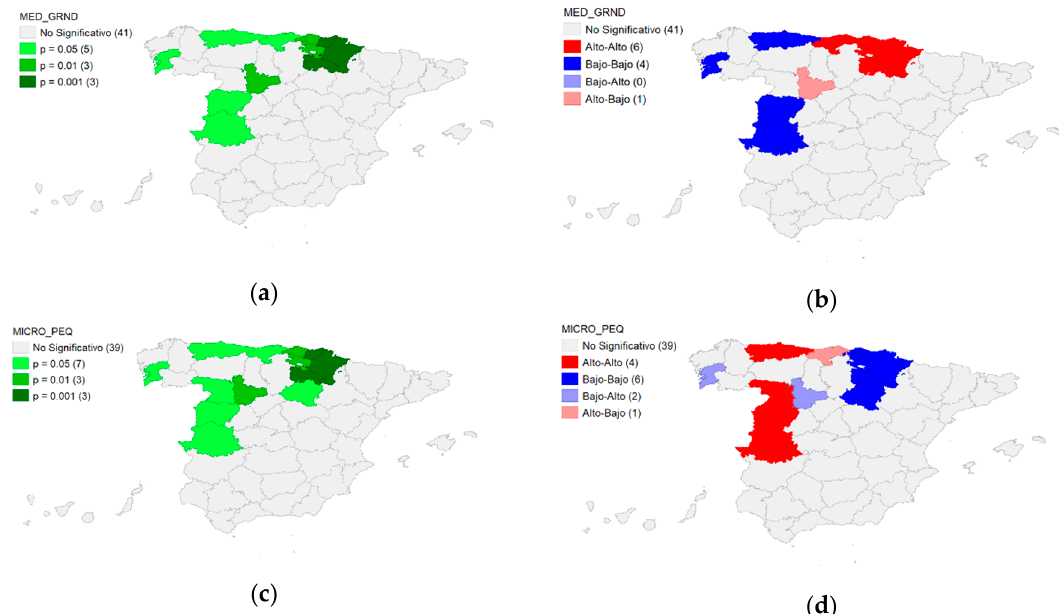
Figure 11. Significance and clusters maps for the variable business size large-medium ( a , b ) and significance and clusters maps for the variable business size small ( c , d ).